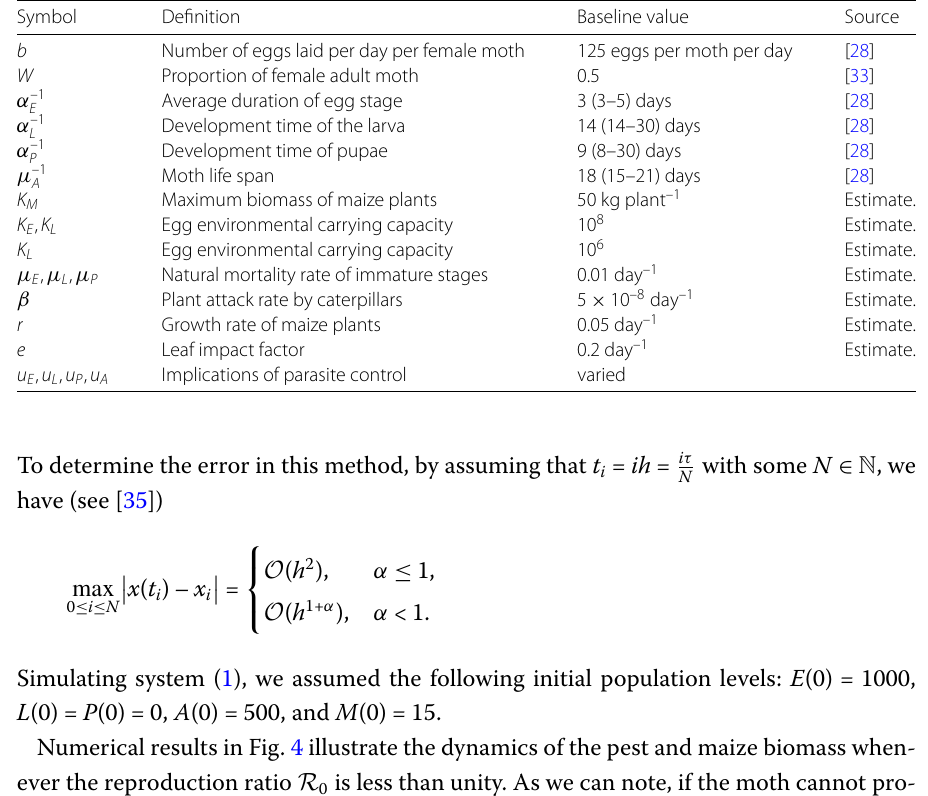
Table 2 Model parameters and their baseline values